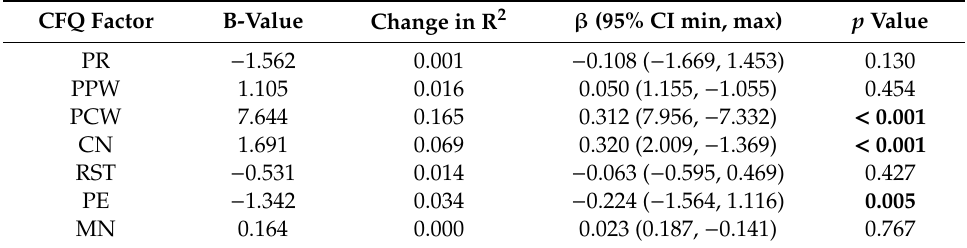
Table 4. Hierarchical linear regression analyses for BMI z-scores on CFQ